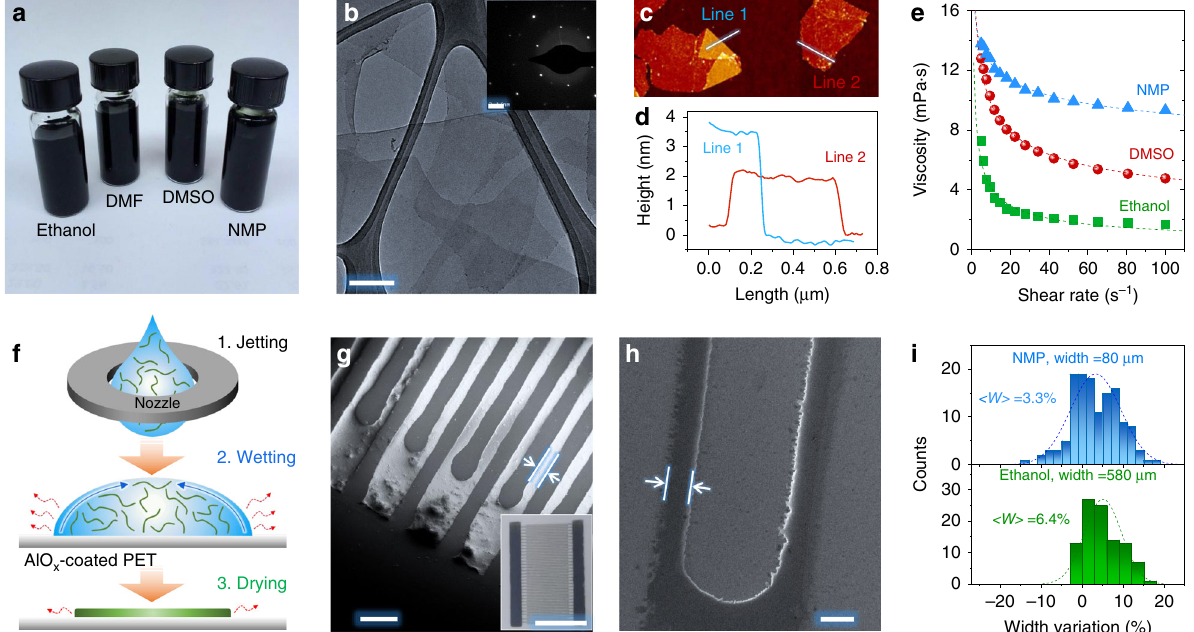
Fig. 2 Characterization of MXene organic inks. a Photos of various MXene organic inks. b TEM image of MXene nanosheets from NMP ink. Inset shows the selected area electron diffraction (SAED) pattern. Scale bar = 200 nm and = 2 1/nm in the inset. c AFM image and d the corresponding height pro fi les along the lines in ( c ). e Viscosity plotted as a function of shear rates for different MXene organic inks. The data were fi tted according to the Ostwald-de Waele power law: η ¼ k γ n (cid:2) 1 , where k and n are the consistency and shear-thinning index, respectively 46 . f Scheme of fi ne resolution of inkjet printing of MXene organic inks. The curved green lines represent MXene nanosheets while the arrows indicate the inward (blue) and outward (red) fl ows of the droplet. Three critical steps, namely, stable jetting, good substrate wetting and droplet drying, control the spatial uniformity of the resultant printed patterns/lines. SEM image of the inkjet-printed MSC using, g the NMP ink (inset shows the whole device) and h the ethanol ink. Scale bar in ( g ) and ( h ) = 200 µ m and = 1 cm in the inset of ( g ). The distances between the two arrows in ( g ) and ( h ) are 50 µ m and 130 µ m, respectively. i width variation of inkjet- printed MXene lines printed using NMP (top) and ethanol (bottom) inks